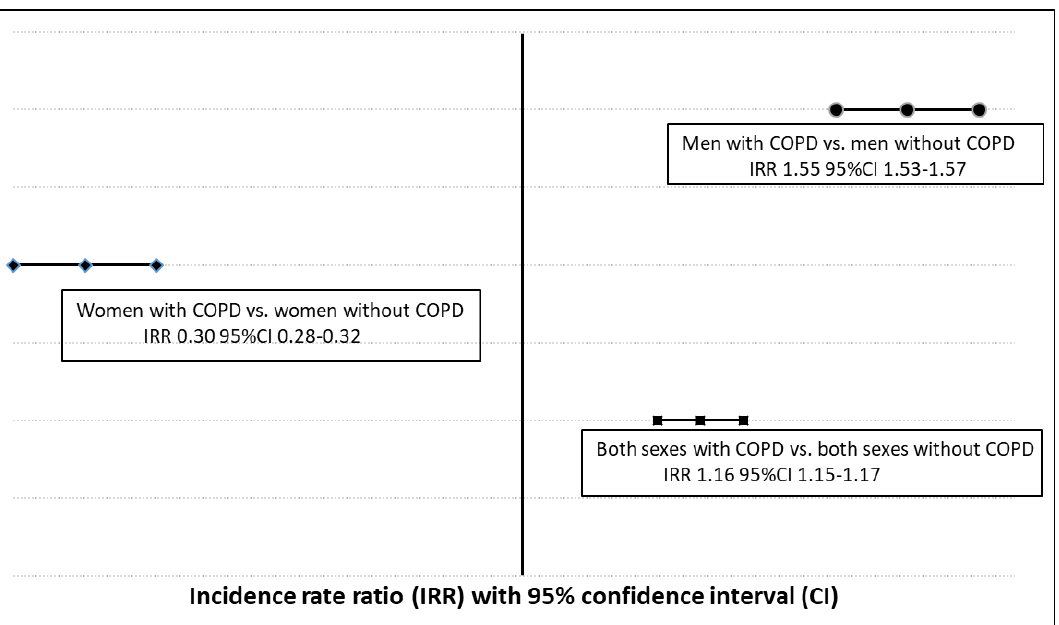
Figure 1. Forrest plot showing adjusted Incidence Rate Ratios for Urinary Tract Infections comparing men and women with and without COPD in Spain from 2001 to 2018. Incidence Rate Ratios obtained with Poisson regression adjusted by age and sex as appropriate.